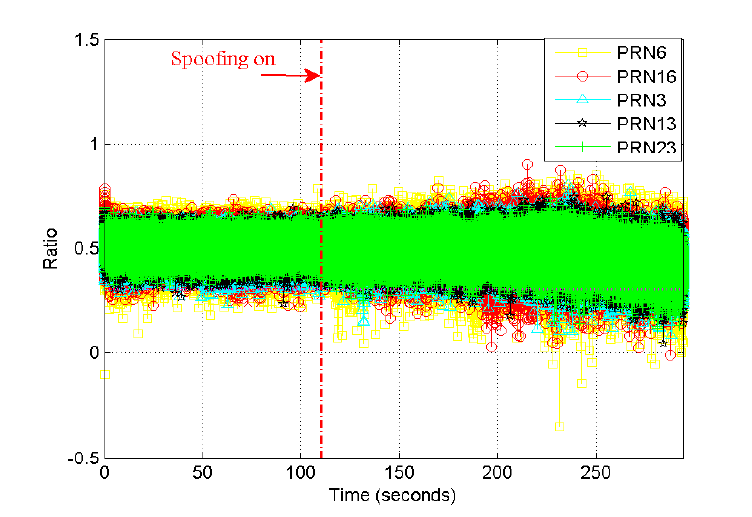
Figure 7. Ratio method curves during an induced spoofing